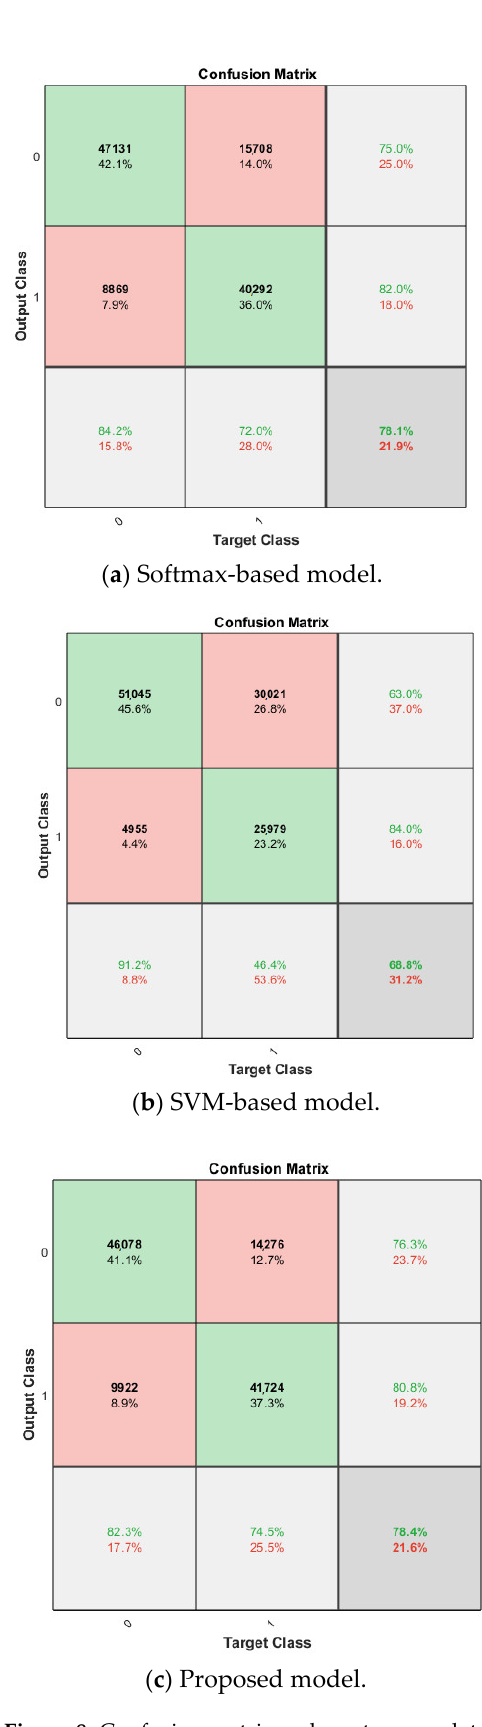
Figure 7. Training progress of the 4-fold cross-validation of the softmax classifier-based model on breast cancer dataset.